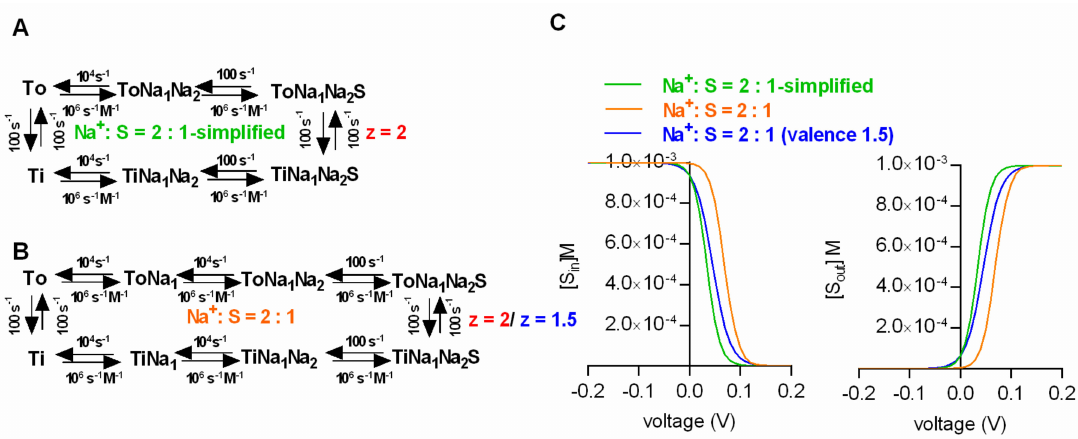
Figure 4. Limits of parsimony. Displayed in ( A ) and ( B ) are the schemes of two kinetic models, which both adhere to a stoichiometry of Na + :S = 2:1. In the scheme in A , both sodium ions bind in a single transition (i.e., simplified model). In B , each sodium ion is allowed to bind individually. ( C ) Intra- and extracellular substrate concentrations at steady state (left and right panel, respectively) for the simplified model in A (green trace), the model in B (orange trace) and for the model in B , but under the assumption that the net-valence does not match the net-charge of the chosen stoichiometry (1.5 vs. 2- blue trace). Only the orange traces match the prediction of the thermodynamic equation in Figure